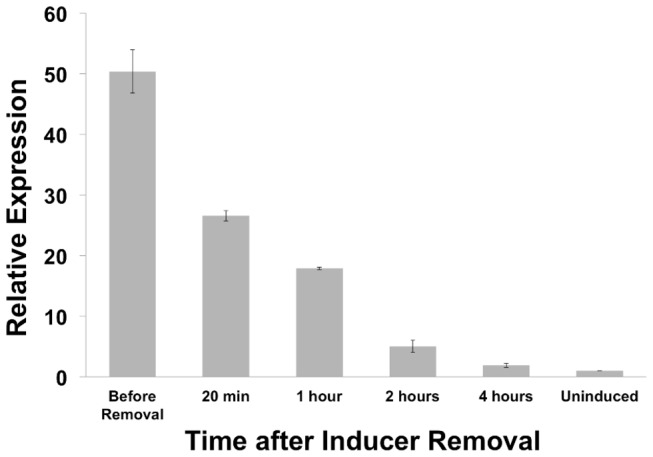
Detection of GFP gene transcription by qPCR.L929 cell cultures infected with pASK-GFP-L2 transformed C. trachomatis were induced with 10 ng/mL ATc from 20-24 hpi. The culture medium was then replaced with ATc-free medium and samples were collected at the indicated time points for processing and analysis of GFP transcription by qPCR. Relative expression levels are in comparison to the uninduced sample. Error bars indicate standard deviation from two separate experiments.